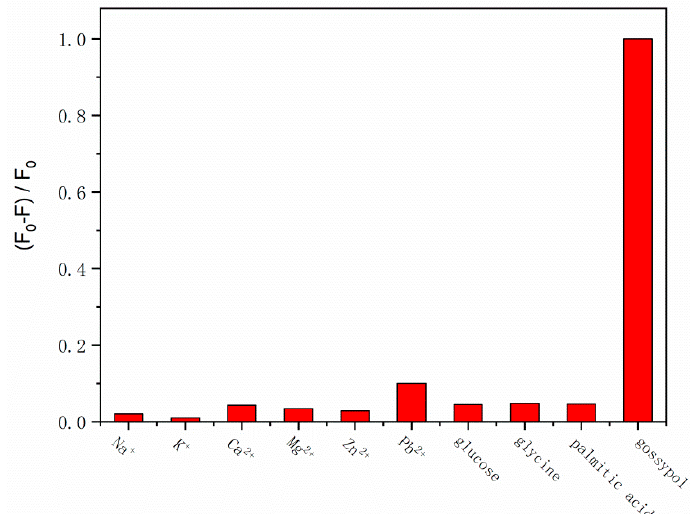
Figure 6. Selectivity of the BSA-Cu NCs over potentially interfering substances. Gossypol: 1 µM; Na + , K + , Ca 2+ , Mg 2+ , and Zn 2+ : 100 µM; glucose, glycine, and palmitic acid: 65 µM.